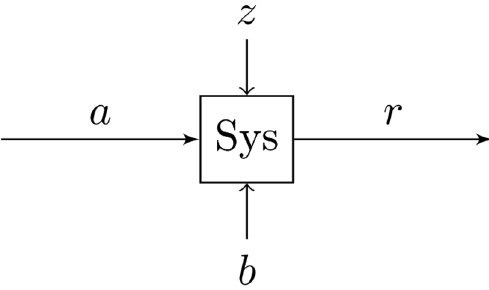
Figure 2. A system at an operating point a with a stochastic disturbance z . The quality of its response r is a function of the parameters given by b , as well as the disturbance z